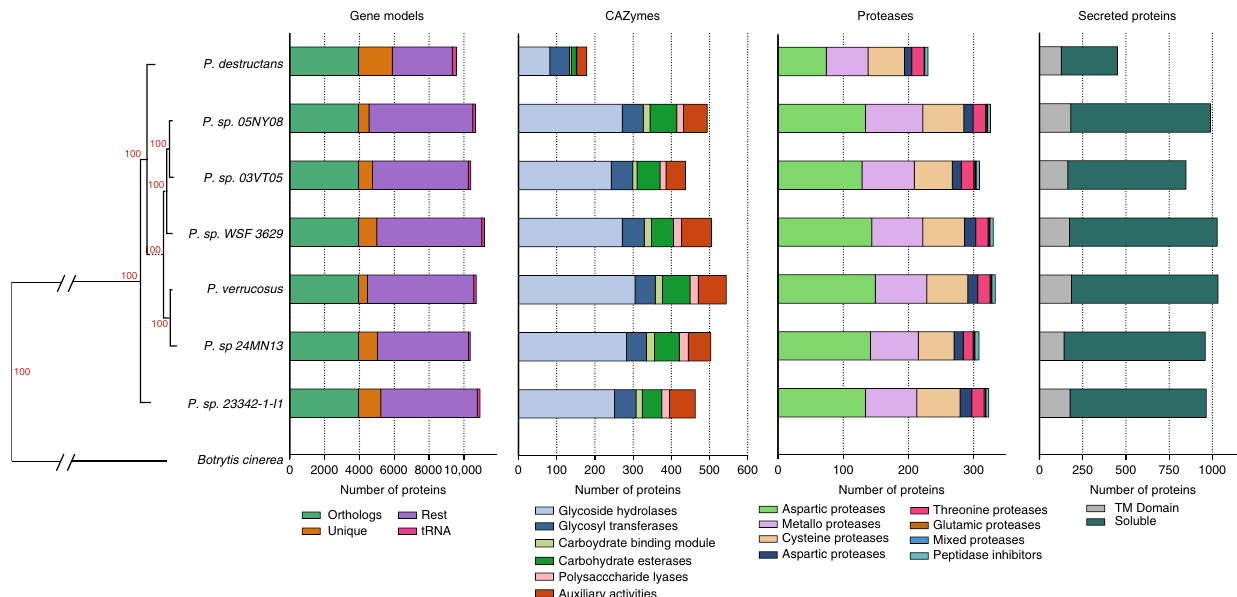
Fig. 2 Comparative genomic analyses of orthologous proteins of Pseudogymnoascus destructans and six close relatives. Maximum likelihood phylogeny illustrates relationships between fungi used in this study. Genome-level comparisons made based on number of gene models, number of CAZymes, number of proteases, and the number of secreted proteins as described in